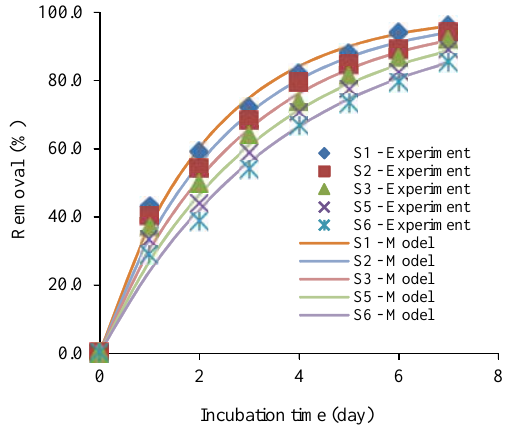
Fig. 6(a): Comparison of experimental and model values by A. niger Fig. 6(b): Comparison of experimental and model values by A. flavus